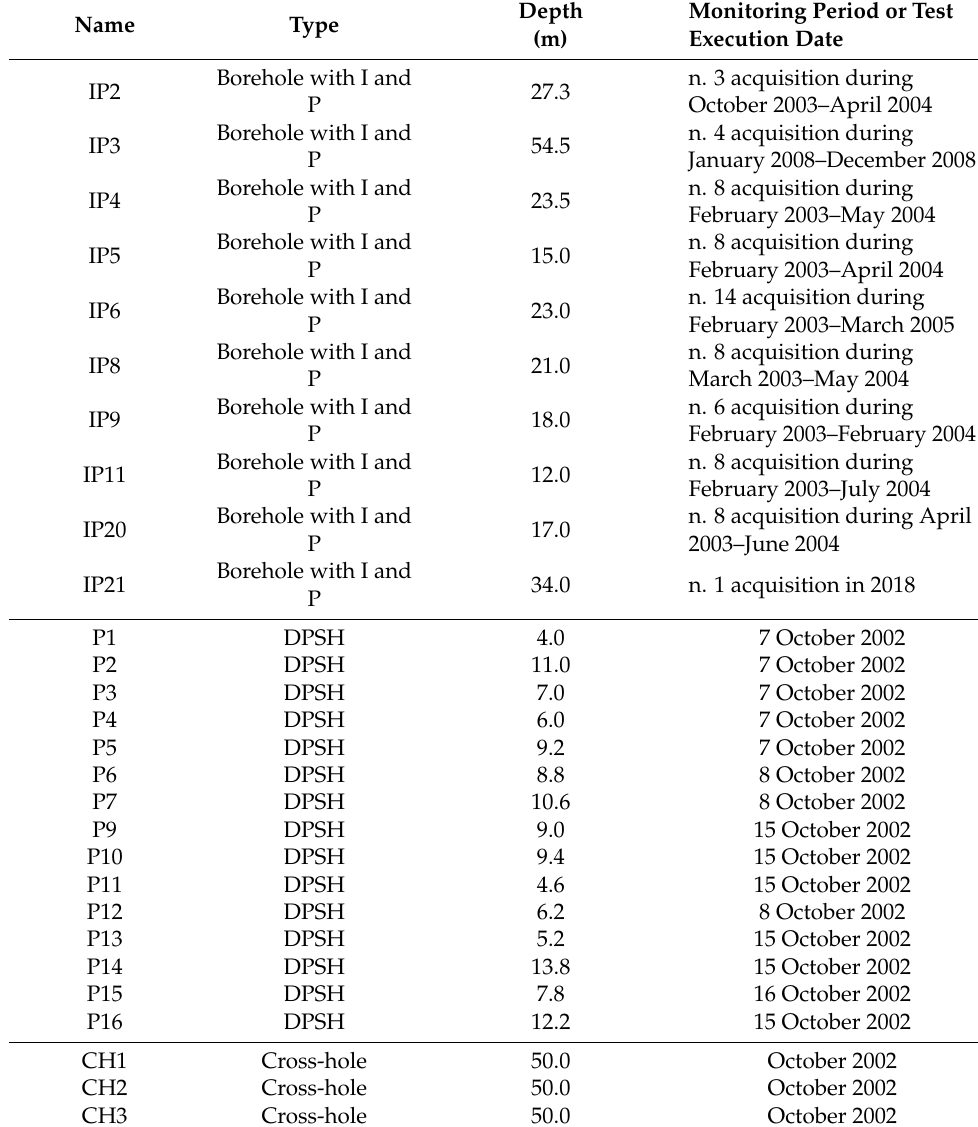
Table 1. Synthesis of instruments, geotechnical and geophysical investigations within the